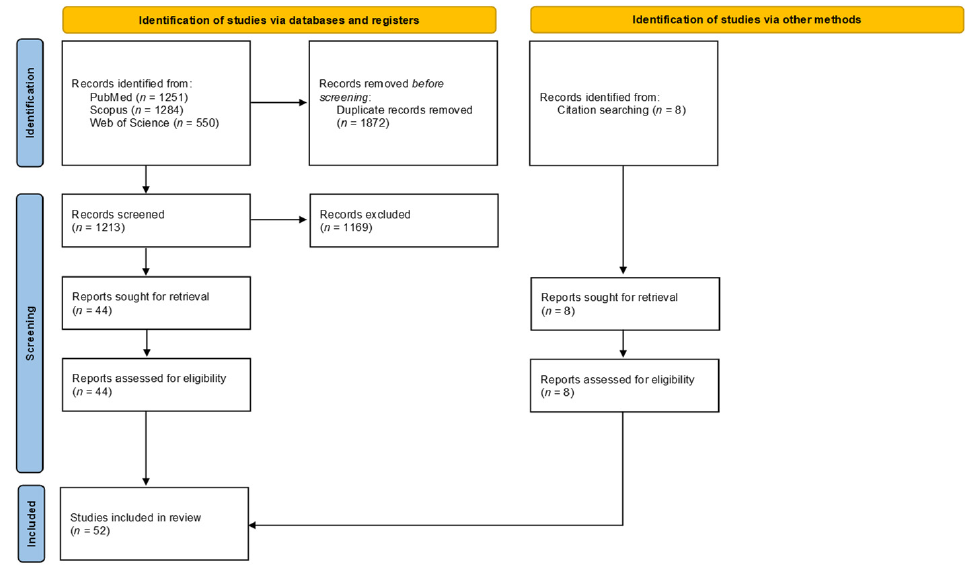
Figure 1. PRISMA inclusion/exclusion process for the systematic review.